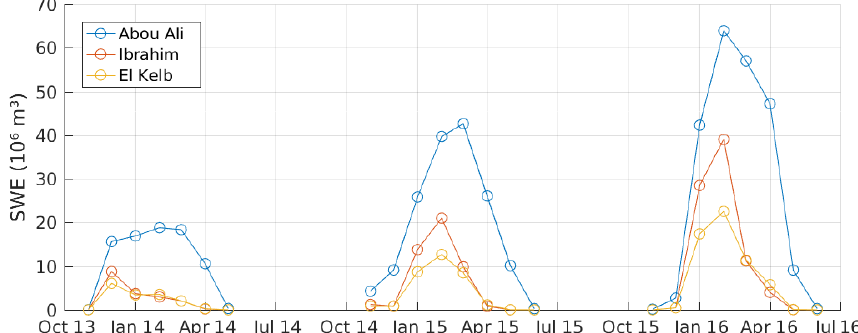
Figure 10. Temporal evolution of the spatially integrated mean monthly SWE in cubic meters (total snow mass in each catchment), based on the Pflug et al. (2019) model outputs.